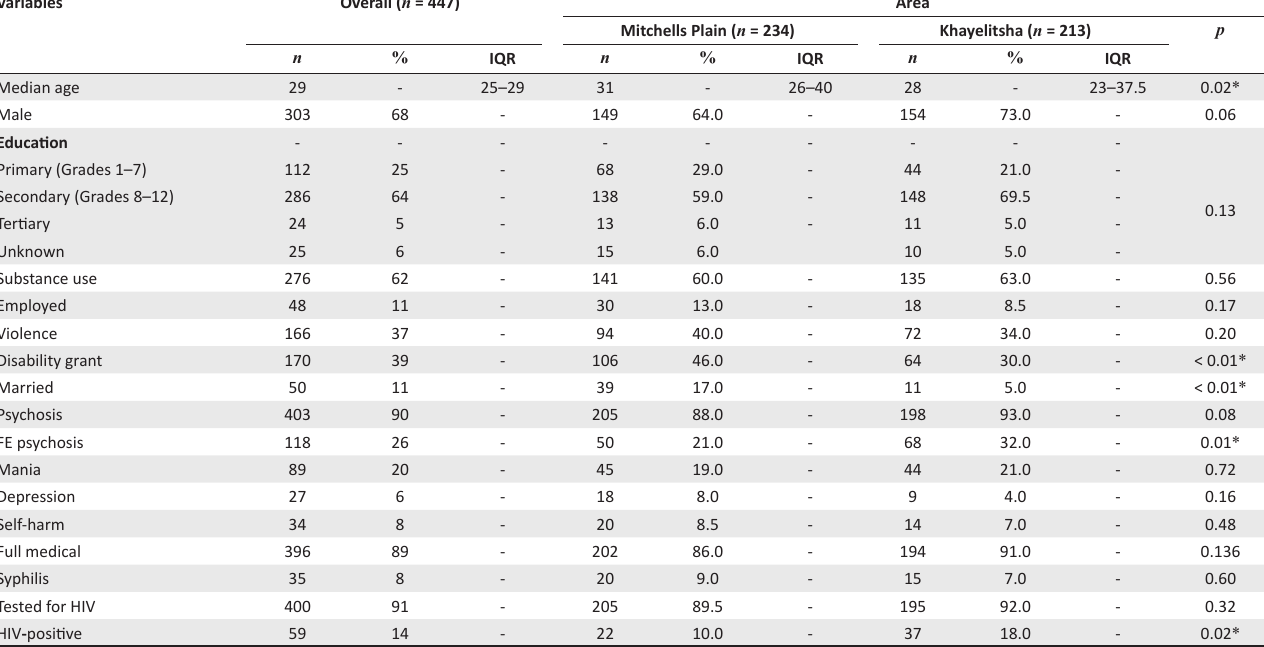
TABLE 2: Demographic and clinical characteristics of patients from Mitchells Plain and